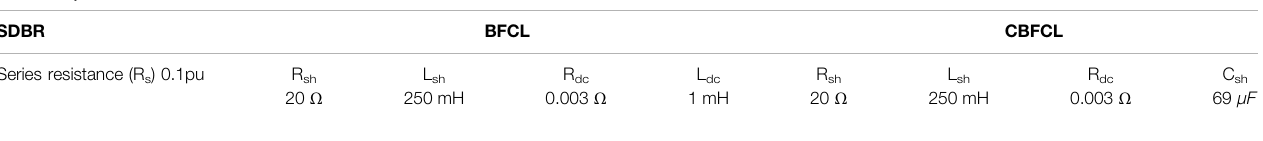
TABLE 2 | Parameters of the fault current limiters. SDBR BFCL CBFCL Series resistance (R s )